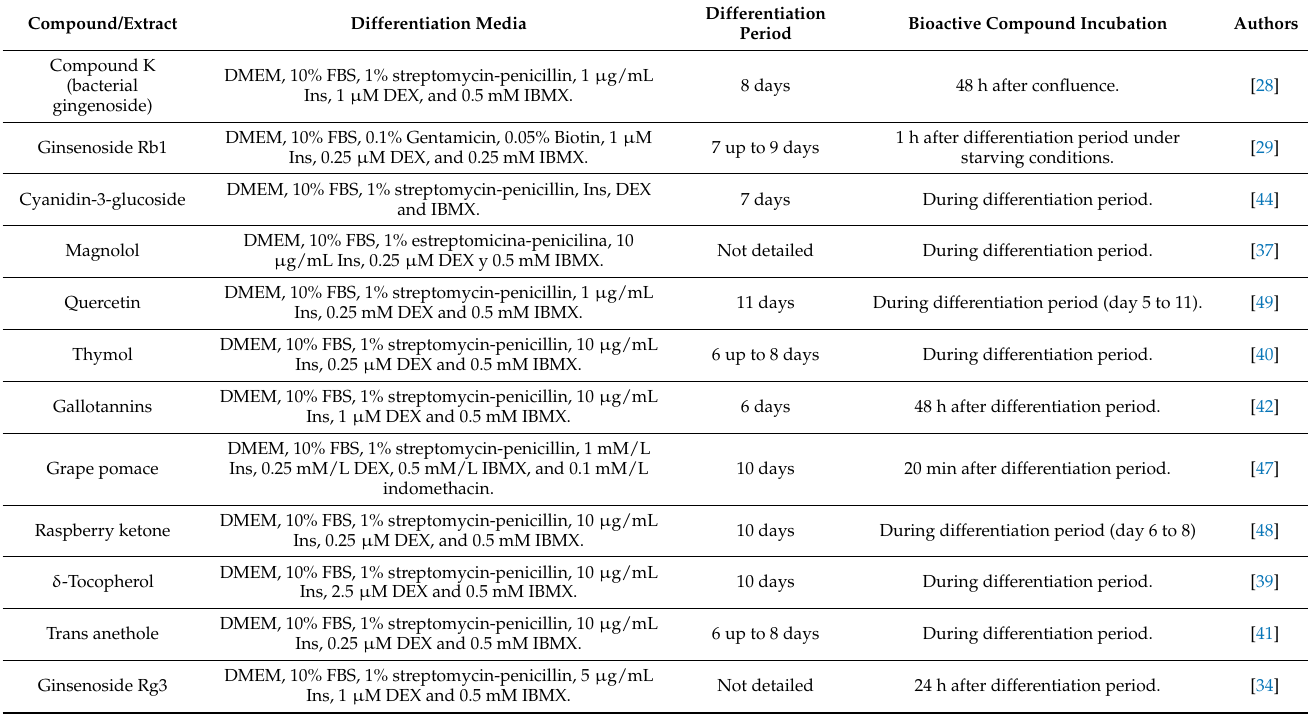
Table 3. Composition of differentiation media and maturation period of different studies related to adipocyte browning performed on the 3T3-L1 and hAMSc cell